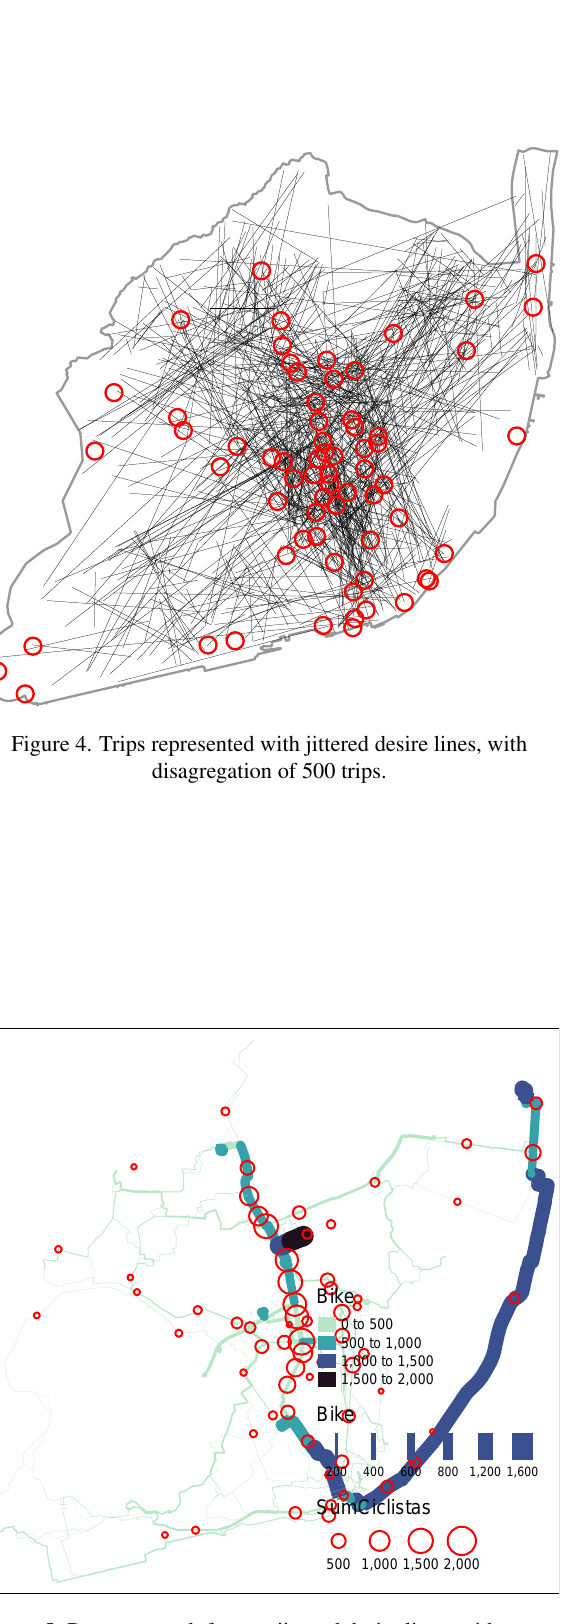
Figure 5. Route network from unjittered desire lines, with routes from CycleStreets, in quietest routing option.